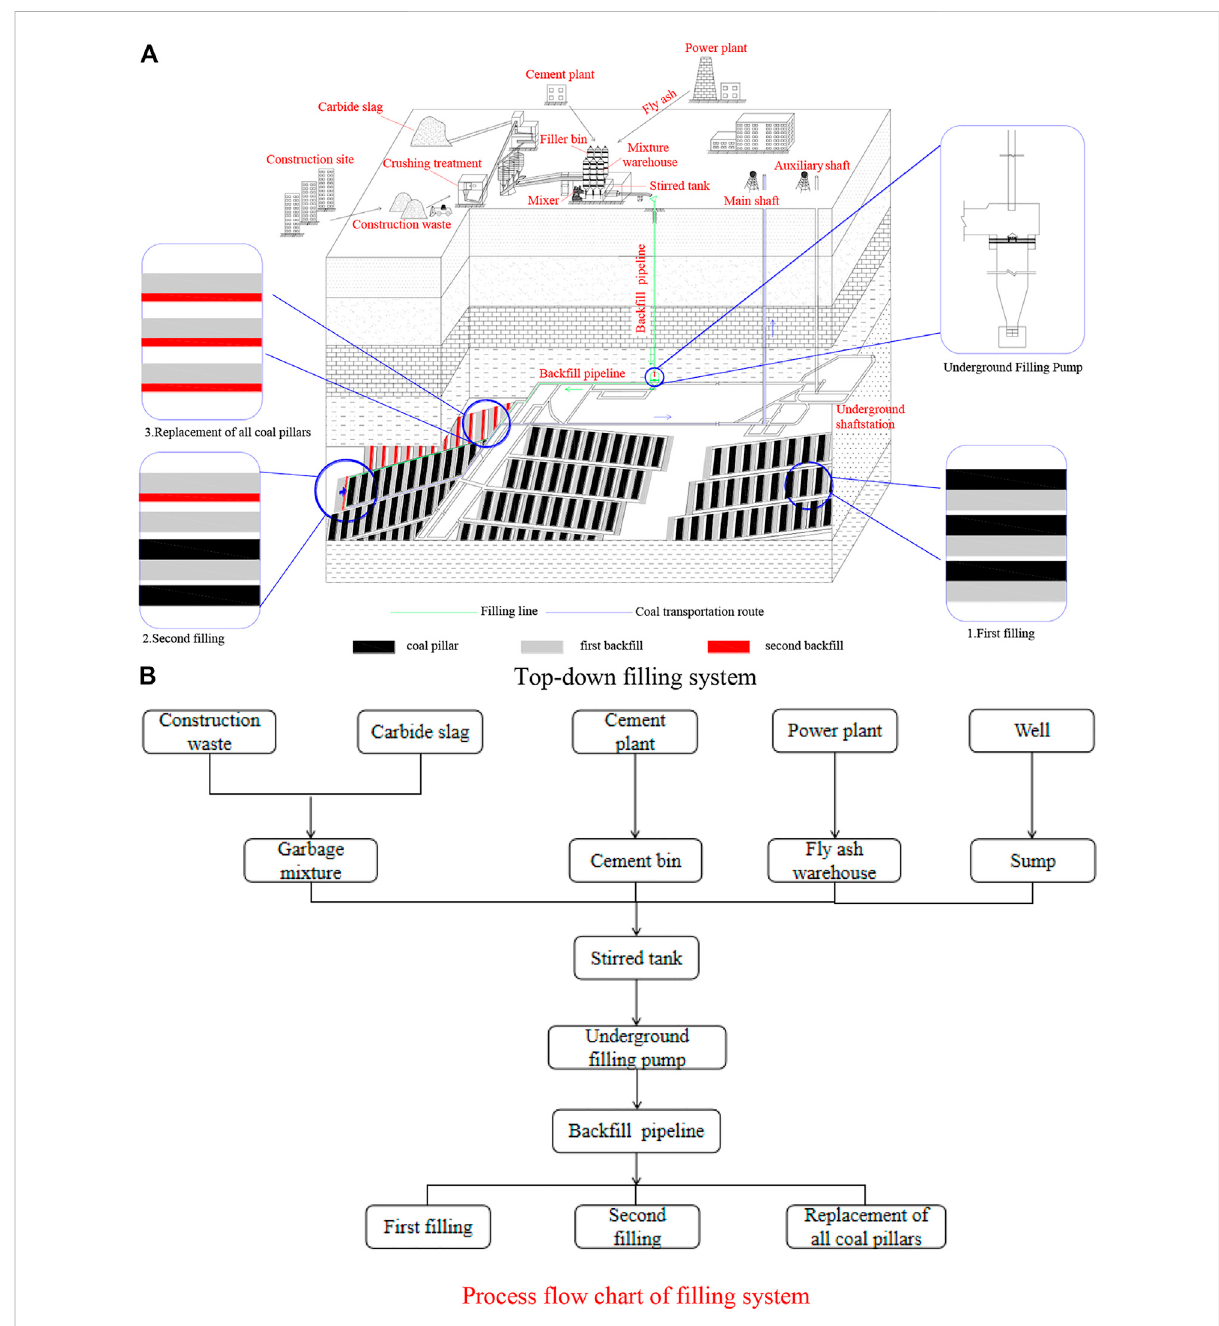
FIGURE 6 Filling system fl ow chart, (A) Top-down fi lling system, (B) Process fl ow chart of fi lling